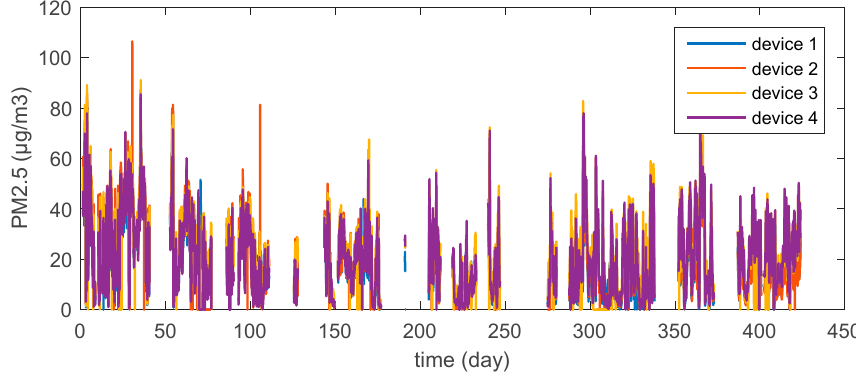
Figure 4. PM2.5 time series of adjacent devices within 5 km.